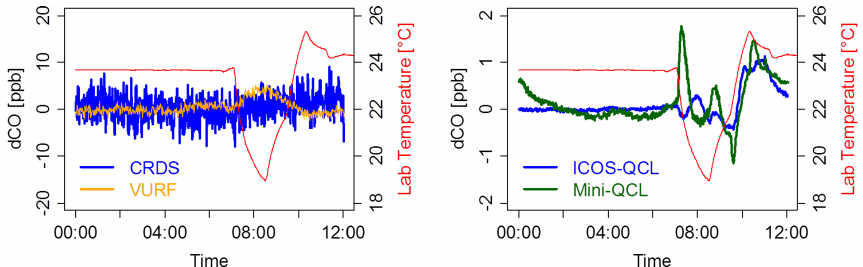
Fig. 5. Influence of the temperature on CO measurements. Left panel: VURF and CRDS, right panel: Mini-QCL and ICOS-QCL, all 1-min data. The deviation of CO (dCO) to the mean value during the period with constant temperature (00:00-07:00LT) is shown on the left axis, and the laboratory temperature (red) is shown on the right